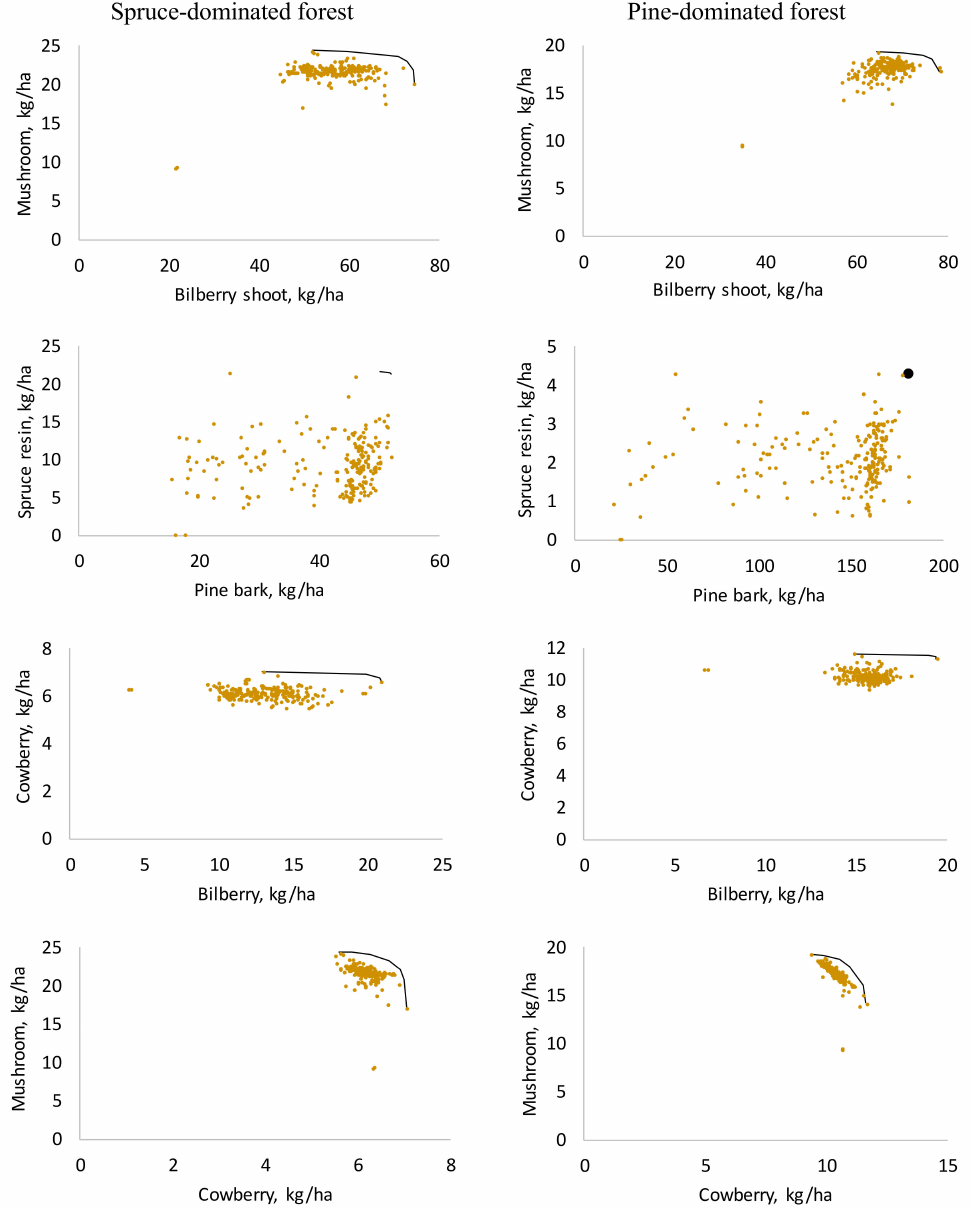
Figure 2. Production possibility frontiers between selected NWFPs (lines) for spruce and pine-dominated forest holdings and the solutions from the created 214 alternative forest plans